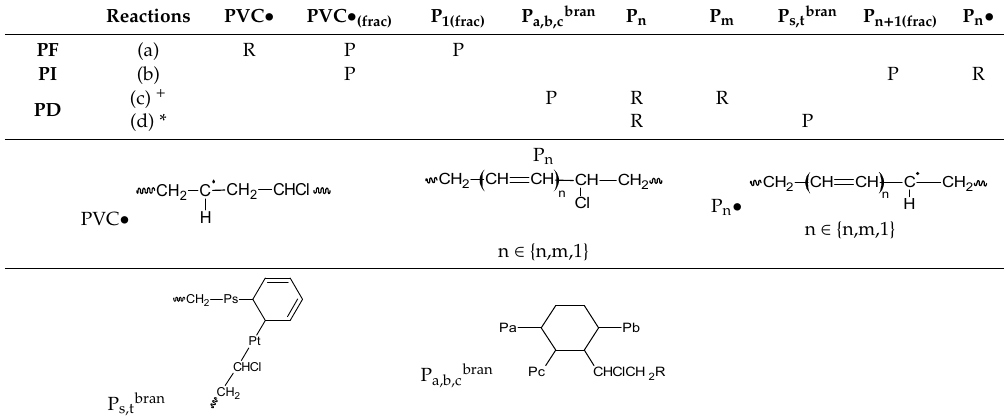
Table 2. Degrading reactions that a ff ect the polyene accumulation behavior and the molecular weight distribution on PVC formulations being photo-thermally oxidized. Table 2. Degrading reactions that affect the polyene accumulation behavior and the molecular weight Table 2. Degrading reactions that affect the polyene accumulation behavior and the molecular weight Table 2. Degrading reactions that affect the polyene accumulation behavior and the molecular weight distribution on PVC formulations being photo-thermally oxidized. Table 2. Degrading reactions that affect the polyene accumulation behavior and the molecular weight distribution on PVC formulations being photo-thermally oxidized. Table 2. Degrading reactions that affect the polyene accumulation behavior and the molecular weight distribution on PVC formulations being photo-thermally oxidized. distribution on PVC formulations being photo-thermally oxidized. distribution on PVC formulations being photo-thermally Reactions